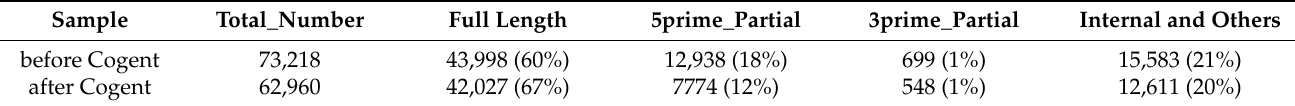
Table 2. Full length statistics with TransDecoder